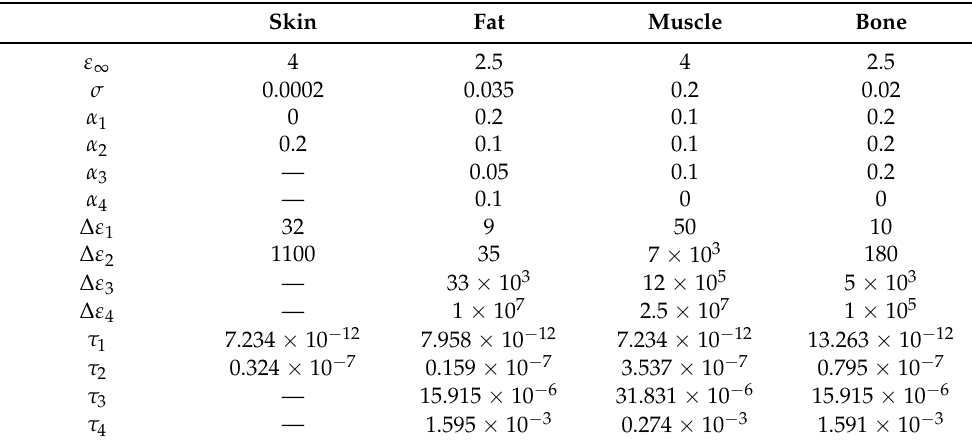
Table 1. Values of parameters for formula (1).